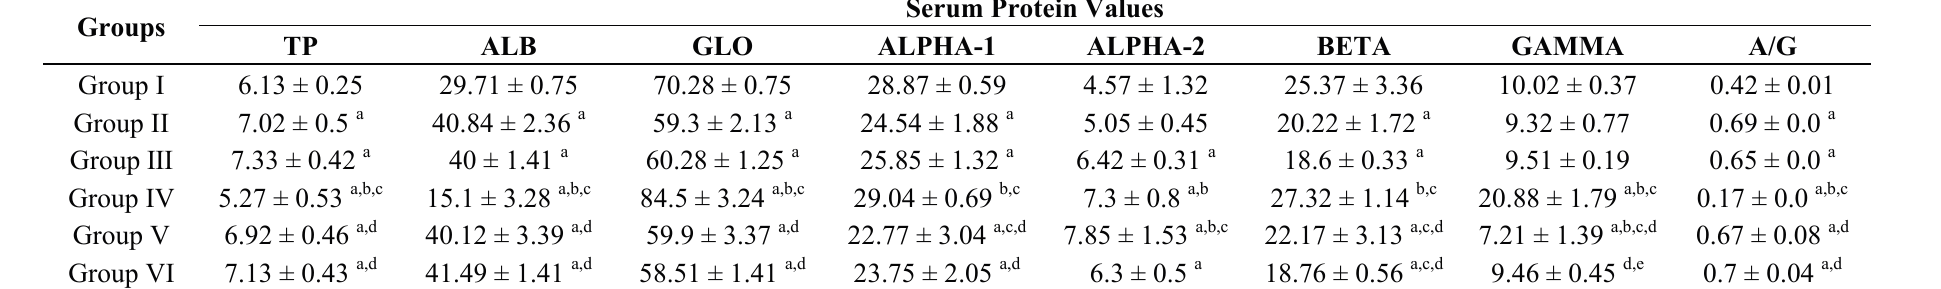
Table 5. Total serum protein profile.